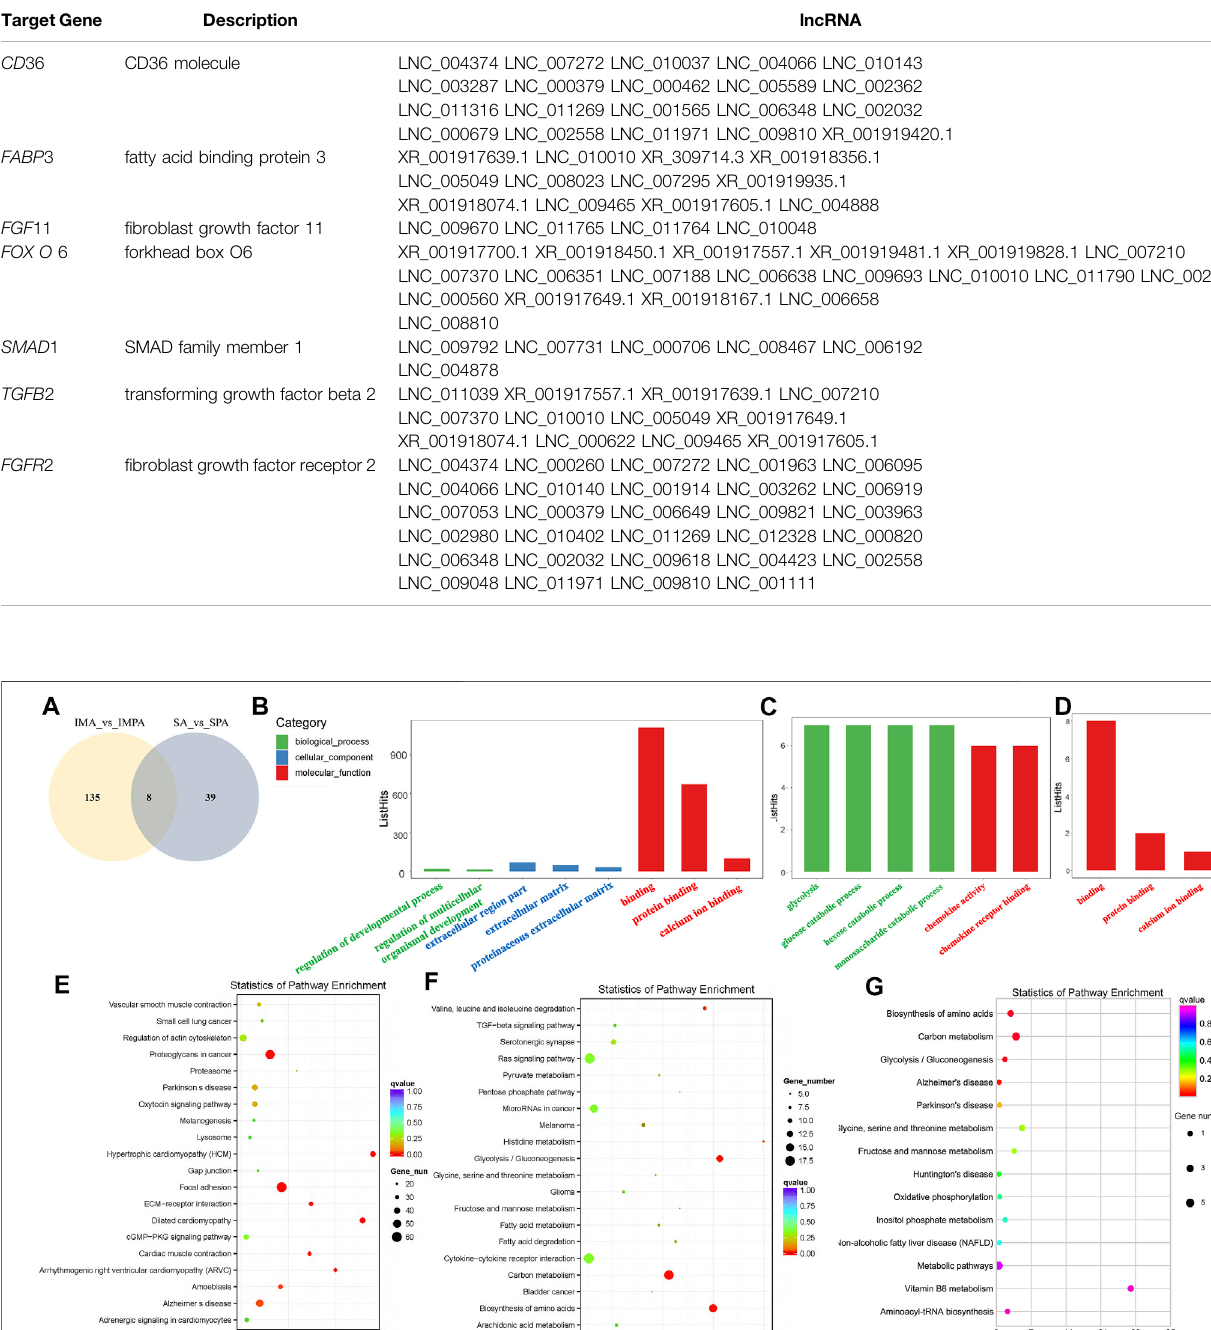
TABLE 4 | Expression of some lncRNAs and their associated genes affecting adipogenesis.